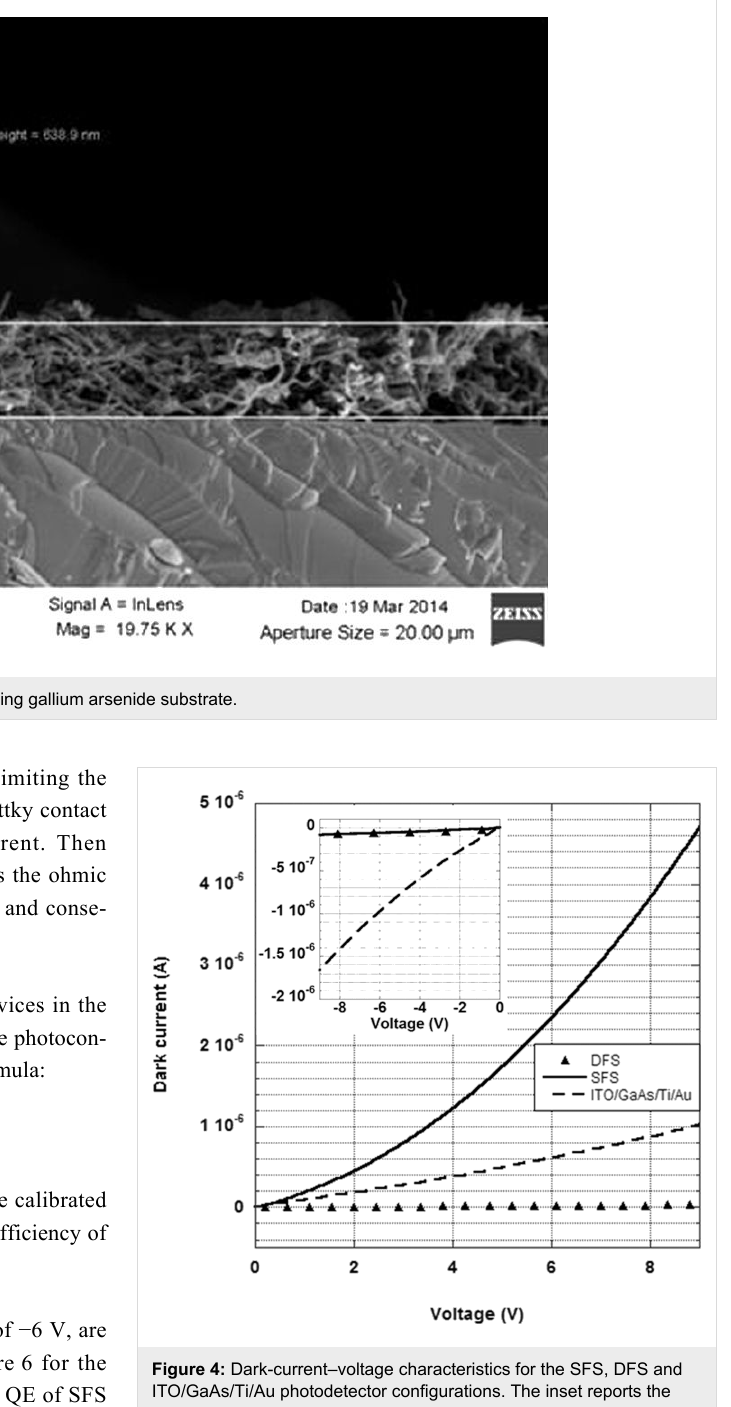
Figure 4: Dark-current–voltage characteristics for the SFS, DFS and ITO/GaAs/Ti/Au photodetector configurations. The inset reports the negative part of the dark-current–voltage